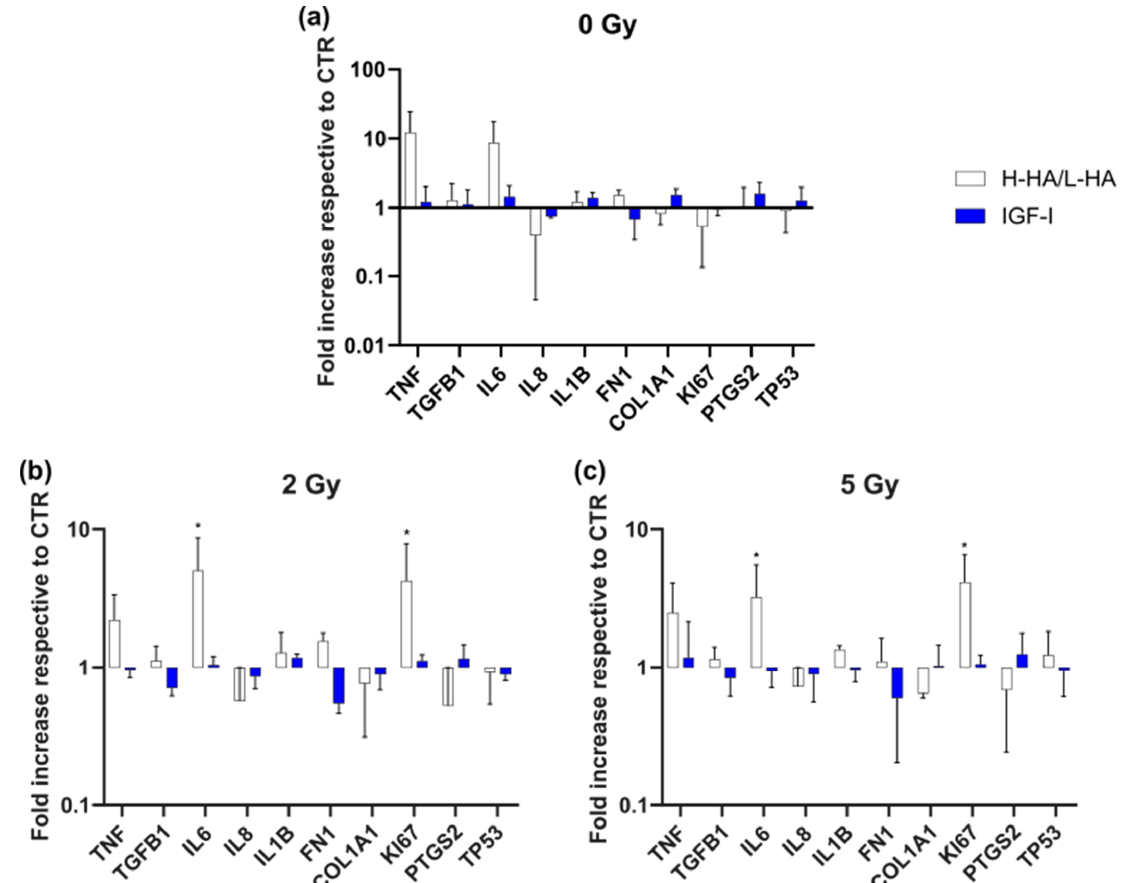
Figure 5. Gene expression of keratinocytes of irradiation groups, 0, 2, and 5 Gy, after 1 mg/mL H-HA/L-HA and 100 ng/mL IGF-I treatment after 24 h. Y-axis shows fold increase respective to control (CTR) (set to 1). ( a ) Gene expression without irradiation ; ( b ) with 2 Gy irradiation; ( c ) with 5 Gy irradiation. * p ≤ 0.05, significances were correlated to the respective control. * = significant compared to the control without growth factors in the respective irradiation dose at the respective time point.